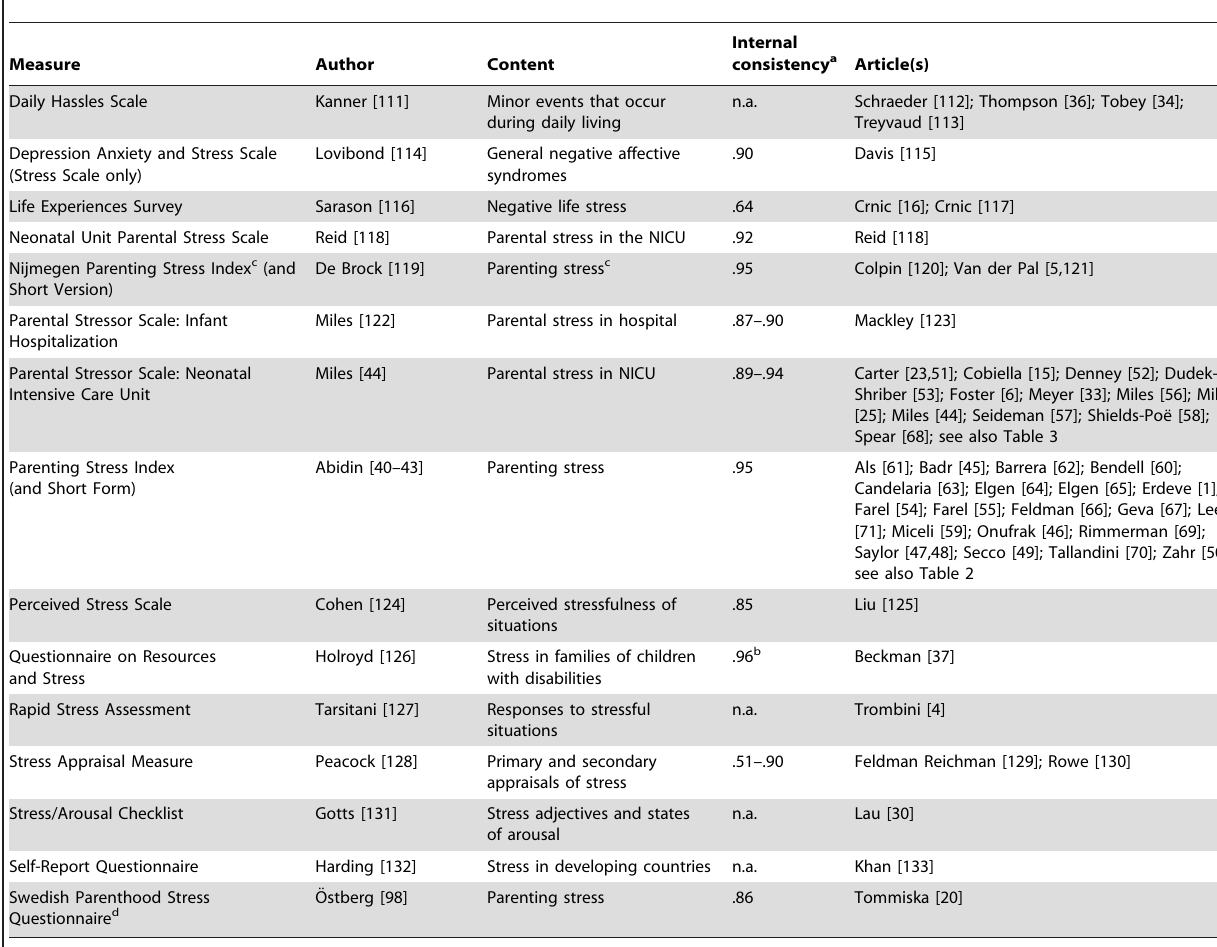
Table 1. Stress Questionnaires Reported by Studies of Parental Stress in Parents of Preterm-Born